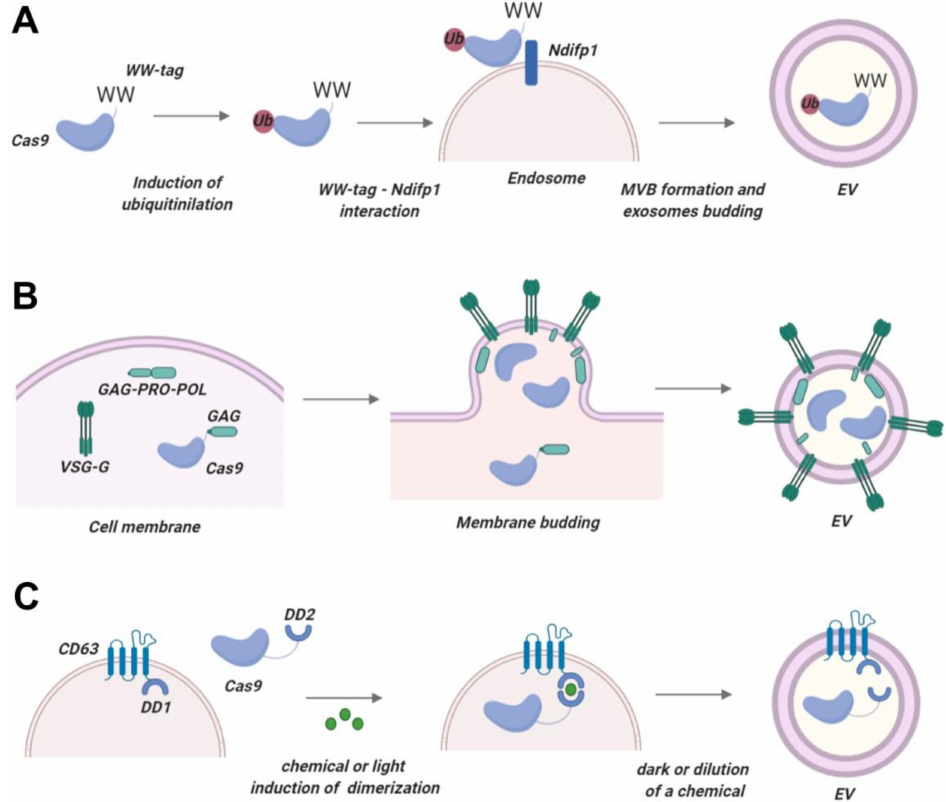
Figure 1. Packaging Cas proteins into EVs. ( A ) Provisional technology based on WW-Ndfip1 interaction. Cas protein with a WW tag can be expressed intracellularly together with Ndfip1. Overexpressed Ndfip1 mediates ubiquitination of Cas-WW and promotes its loading into EVs. ( B ) Nanoblade technology. Virus-like particles are generated by Cas protein fused with HIV Gag and co-expressed with Gag-Pro-Pol protein. Resulting EVs exhibit minor carry-over of cytosolic matter and e ff ectively enter target cells. ( C ) Provisional technology based on the fusion of a constitutive EV membrane protein (e.g., CD63) with a dimerization domain and the use of a hybrid Cas protein with another dimerization domain. Upon signal (light or a chemical molecule), domains dimerize and Cas protein is recruited into EVs. Post-production, the signal is removed, and the Cas protein is released into the EV lumina. This picture was created in